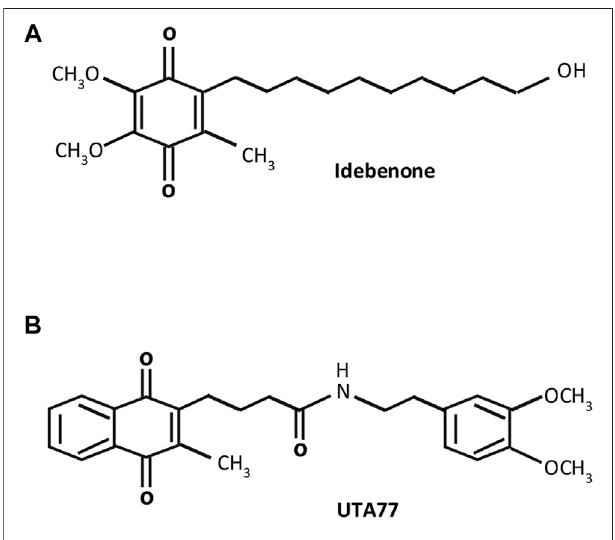
FIGURE 1 | Molecular structures of short-chain quinones (SCQs). (A) Benzoquinone idebenone and (B) novel naphthoquinone